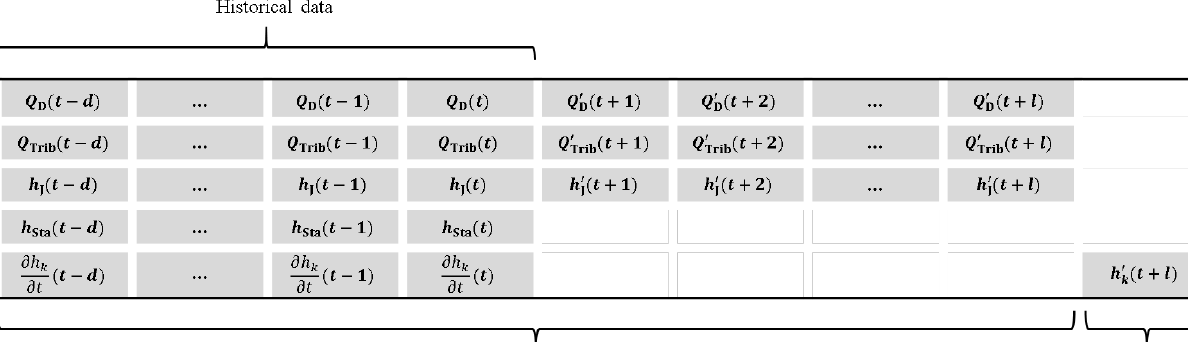
Figure 8. Input candidates and output for ANN2.